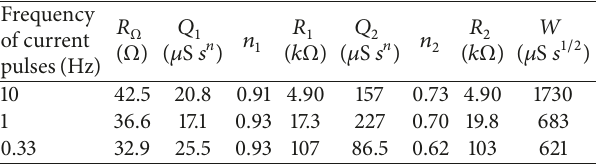
Table 1: Impedance parameters obtained using the circuit model of Figure